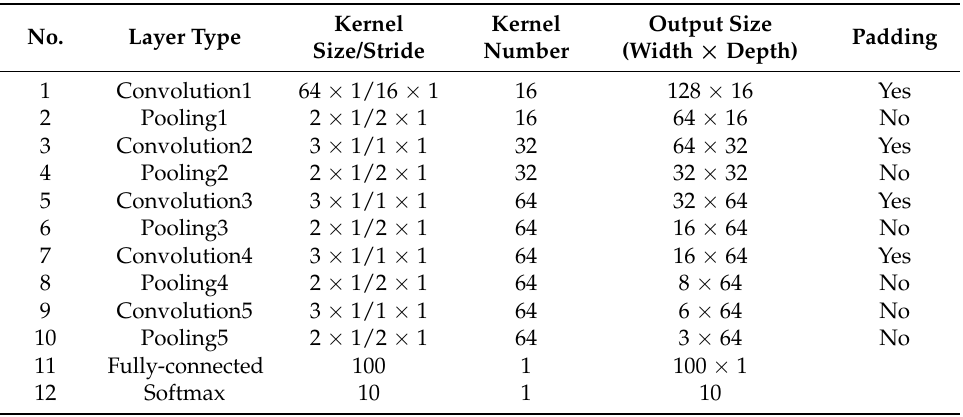
Table 2. Details of proposed WDCNN model used in